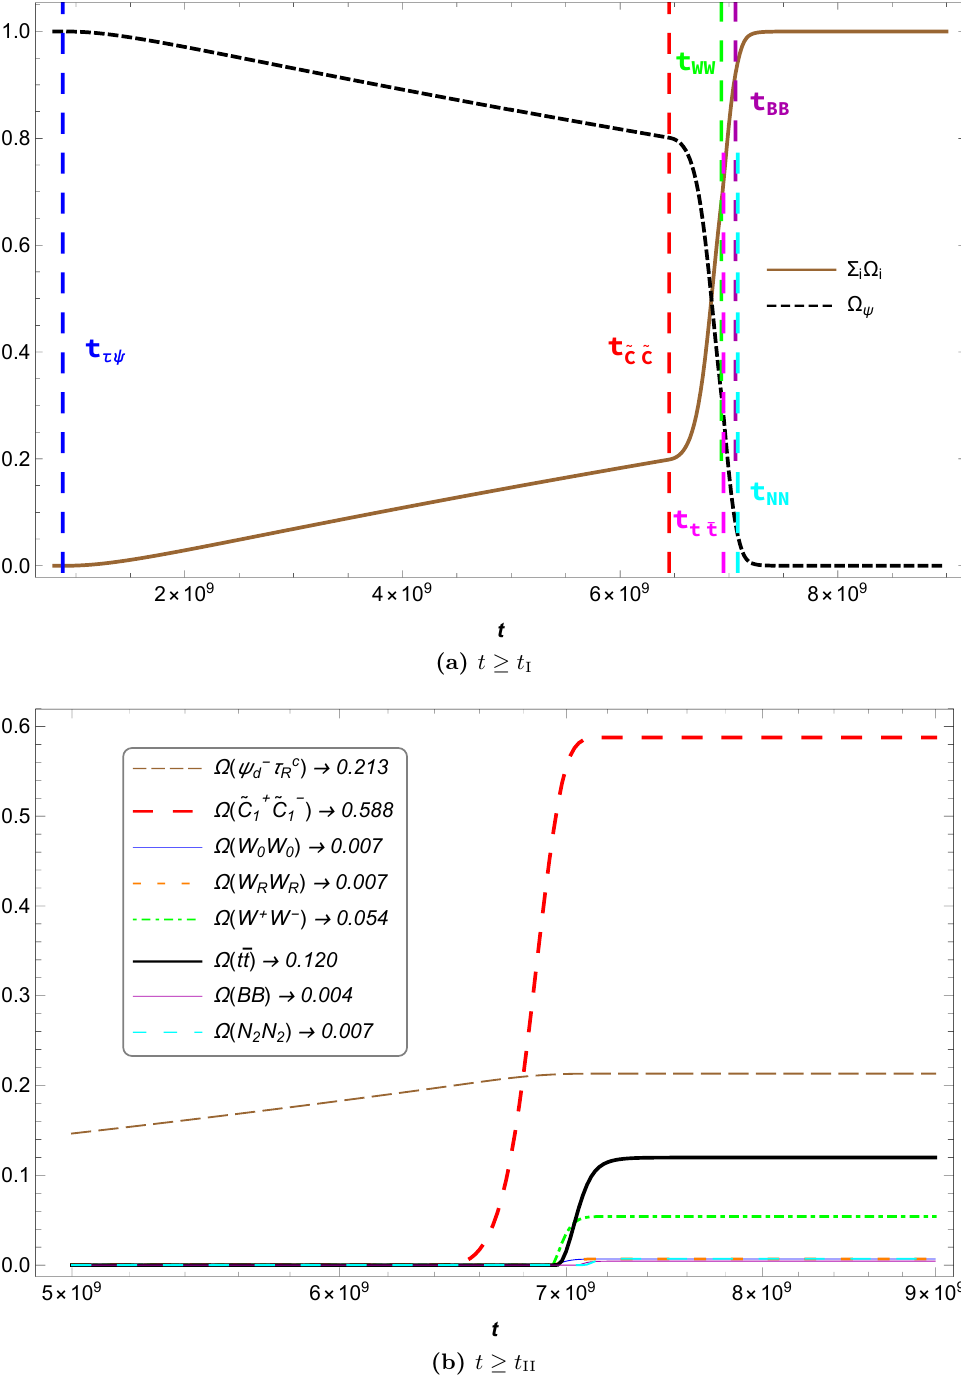
(cid:10) i from t I to sometime after the end i = 6 : 95 (cid:2) 10 9 , t BB (cid:3) = 7 : 06 (cid:2) 10 9 and t (cid:22) t (cid:3)